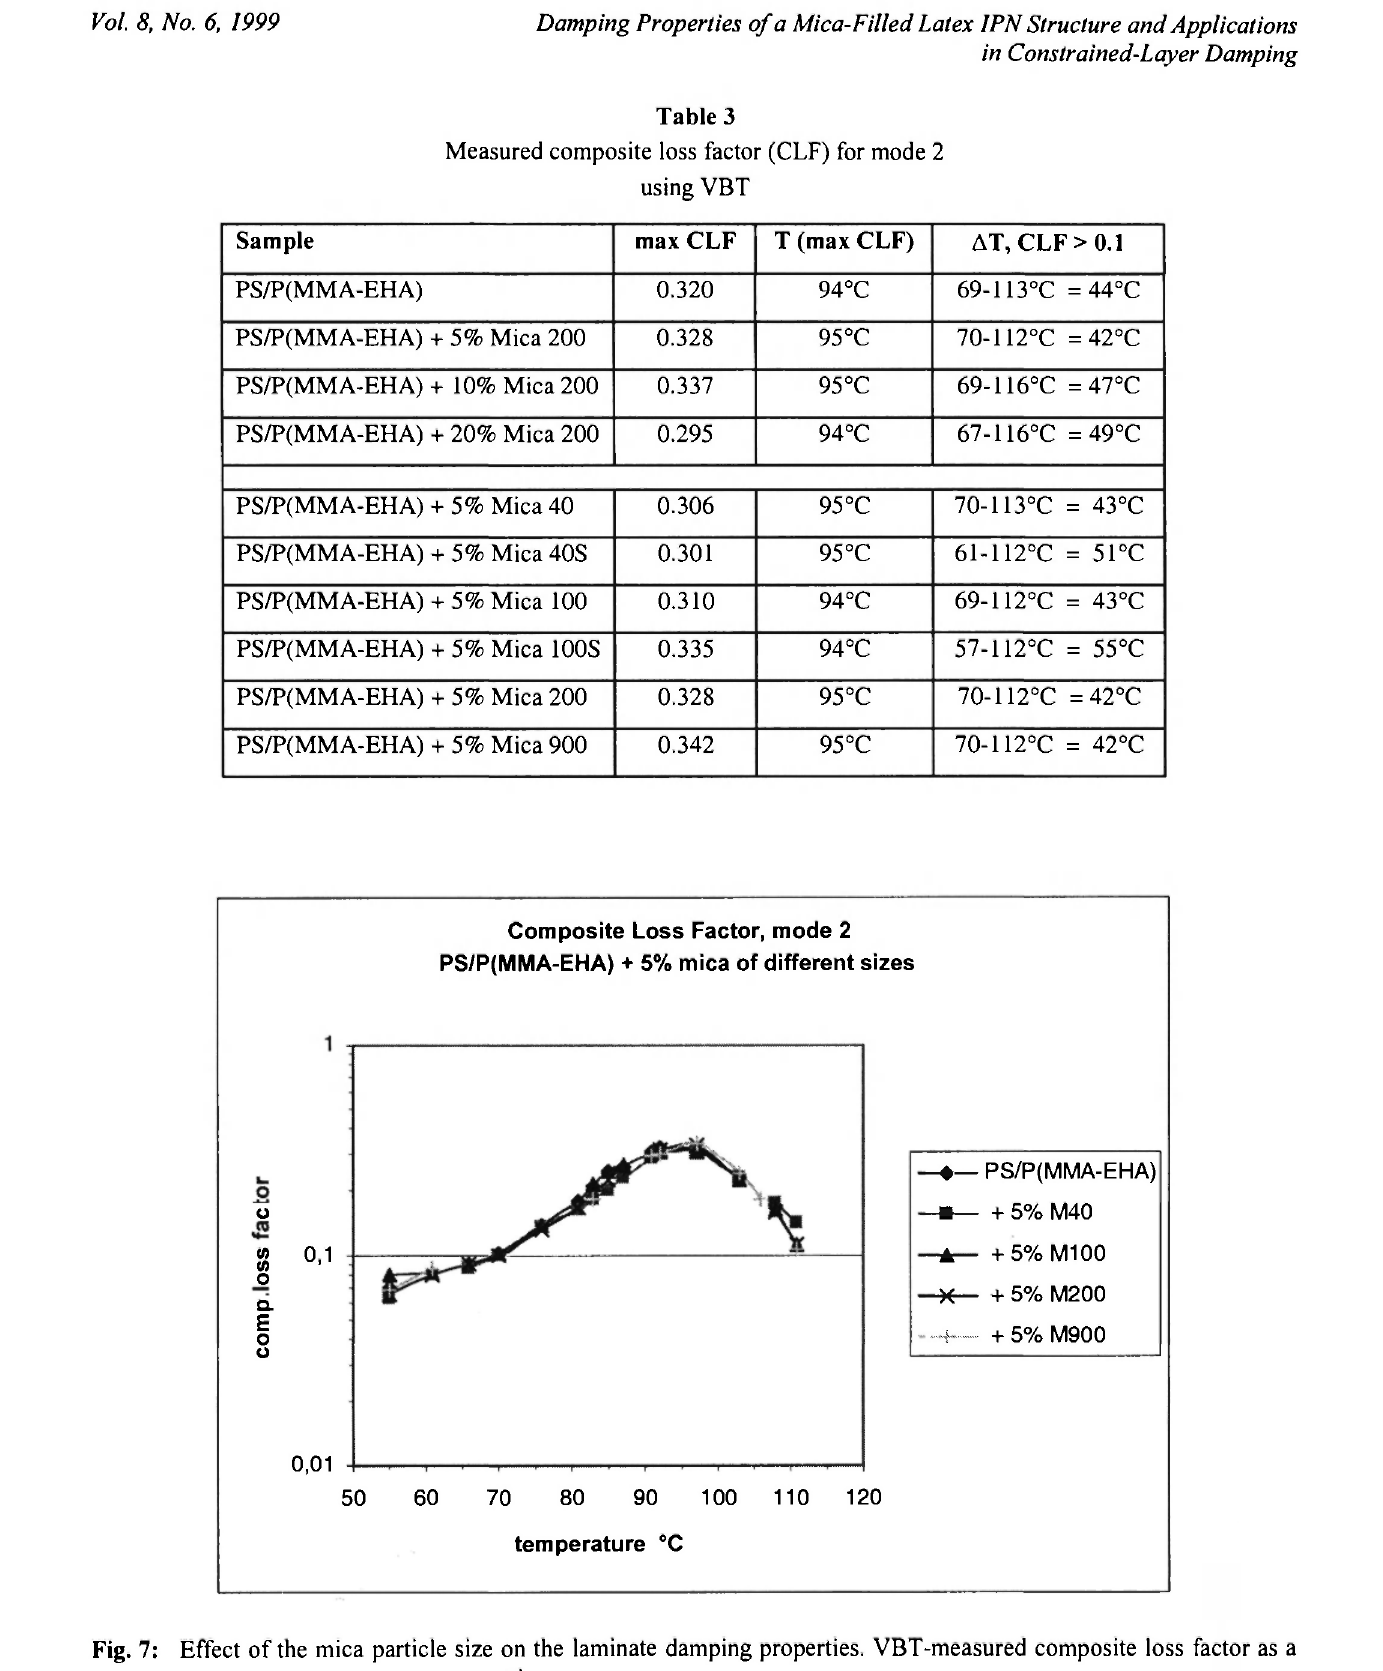
Fig. 7: Effect of the mica particle size on the laminate damping properties. VBT-measured composite loss factor as a function of temperature for the 2 nd vibration